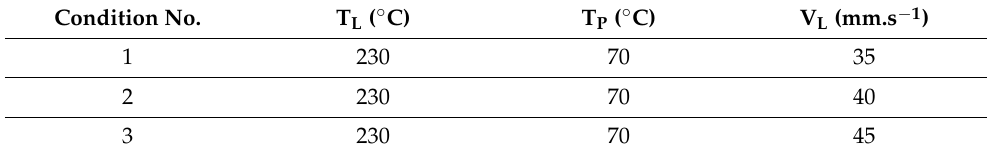
Table 3. Optimized conditions according to the RSM fitting and optimization of the responses. Condition